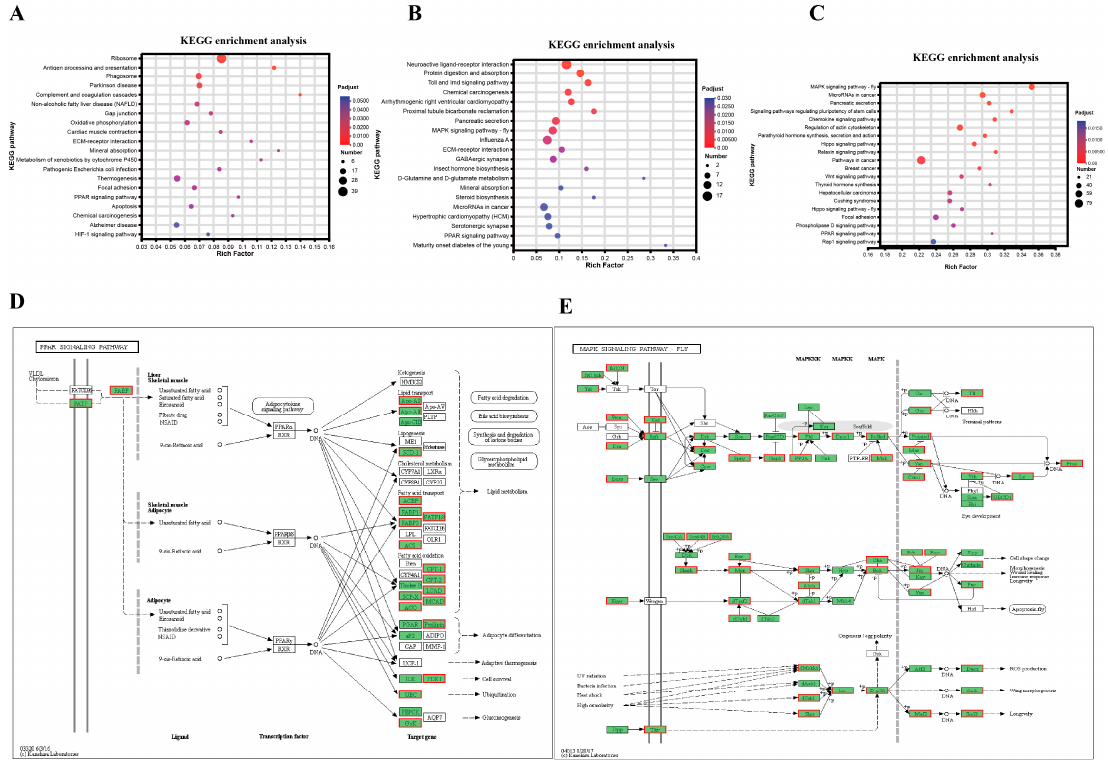
Figure 6. KEGG enrichment of DEGs in the different comparison groups. ( A ) Total number of DEGs in the vitellogenesis stages of SOMP (S_OV_4_vs_S_OV_3; S_OV_5_vs_S_OV_4); ( B ) Total number of DEGs in the vitellogenesis of FOMP (F_OV_4_vs_F_OV_3; F_OV_5_vs_F_OV_4); ( C ) Total number of DEGs in the comparison groups between the SOMP and FOMP during vitellogenesis (S_OV_3_vs_F_OV_3; S_OV_4_vs_F_OV_4; S_OV_5_vs_F_OV_5); ( D ) PPAR signaling pathway; ( E ) MAPK signaling